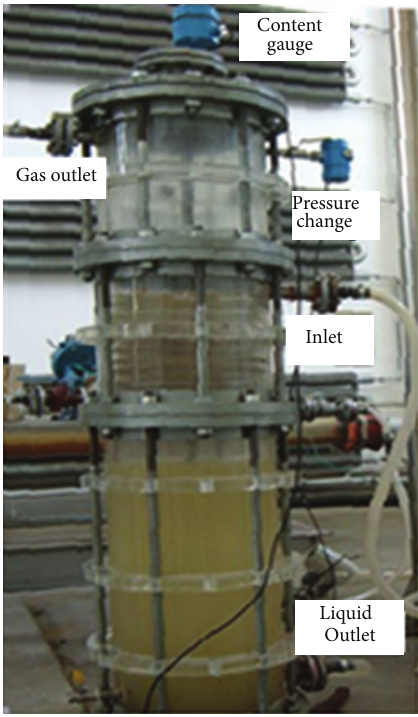
Figure 1: The separator